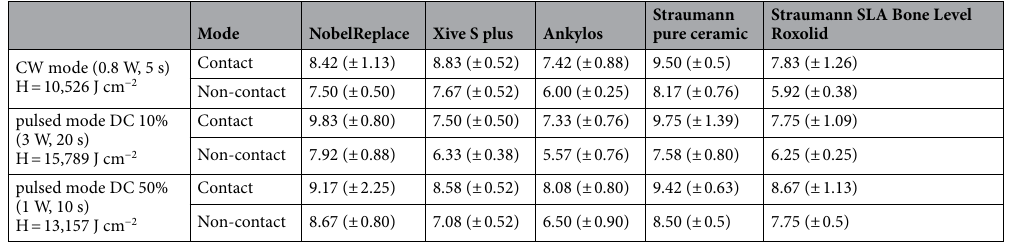
Table 1. Maximal cervical temperature increases (∆T [°C], mean ± SD) following 445 nm laser irradiation in five dental implant systems. Both continuous wave and pulsed modes were applied in contact and non-contact mode. DC duty cycle (%), CW continuous wave.